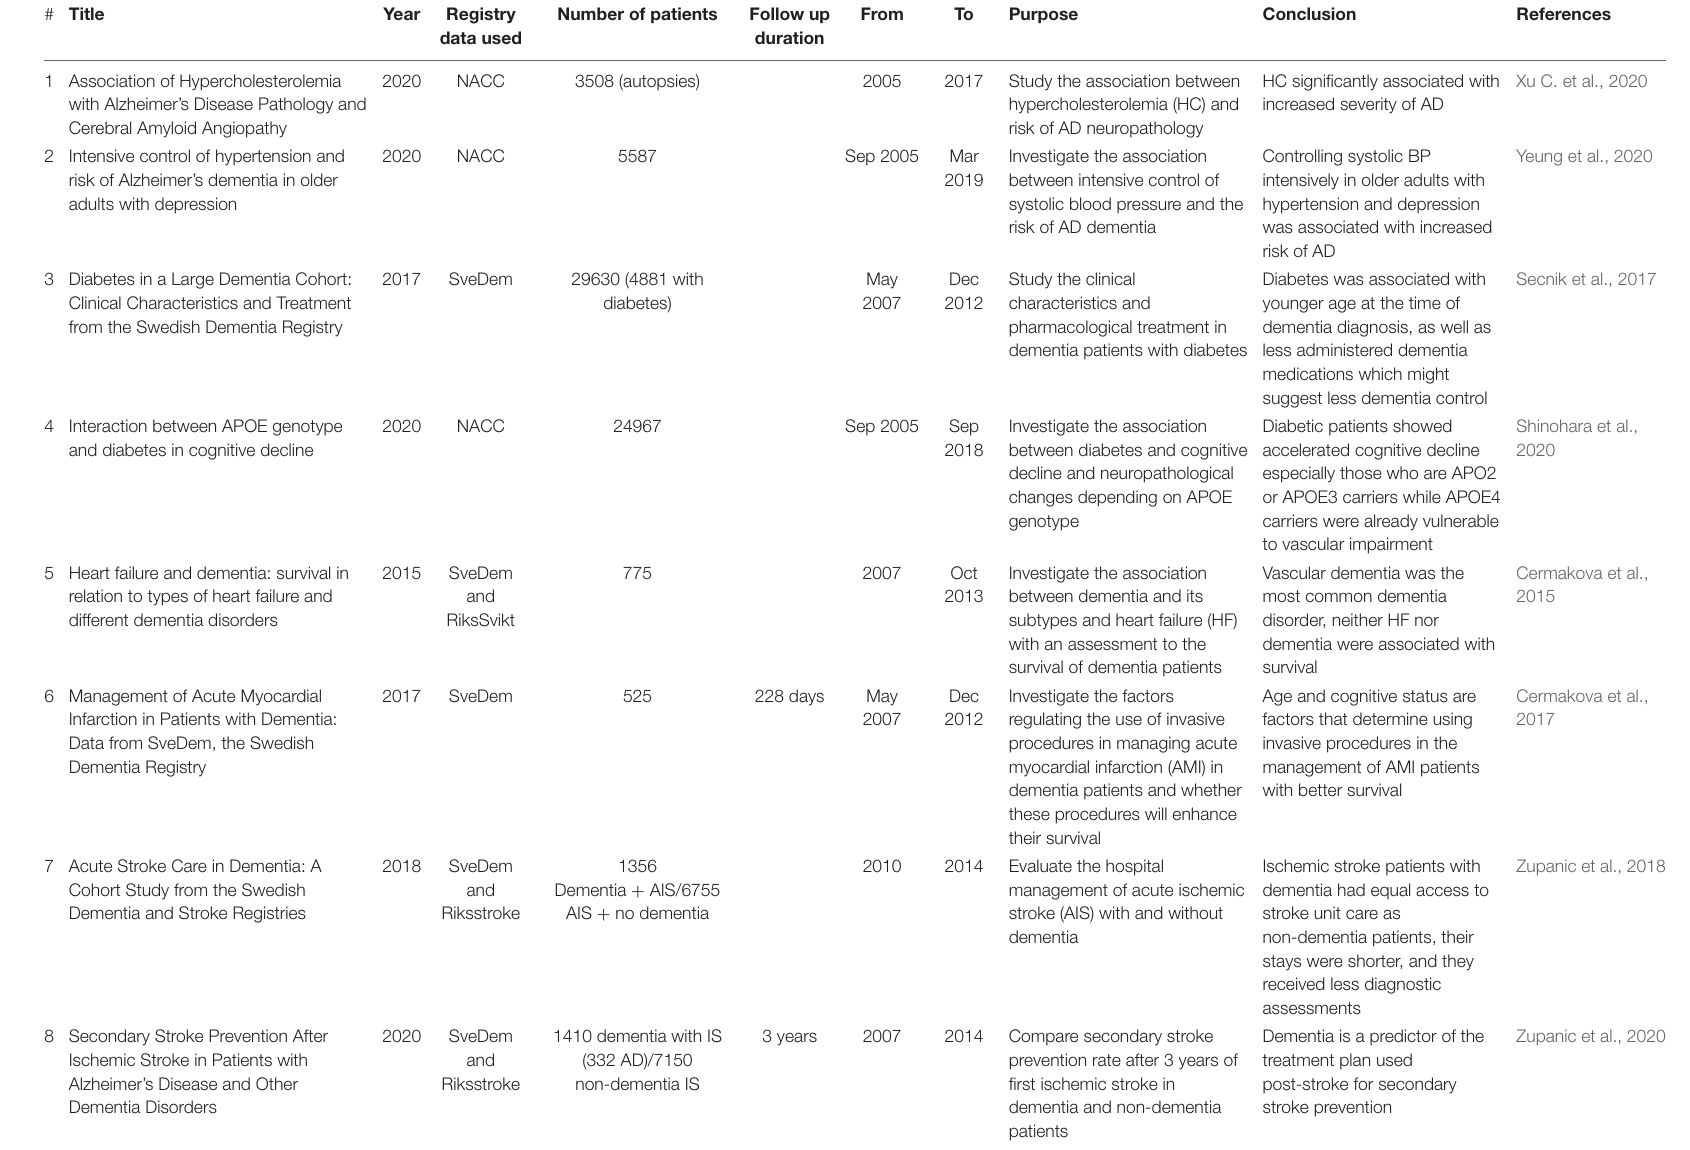
TABLE 5 | Registry-based studies on dementia